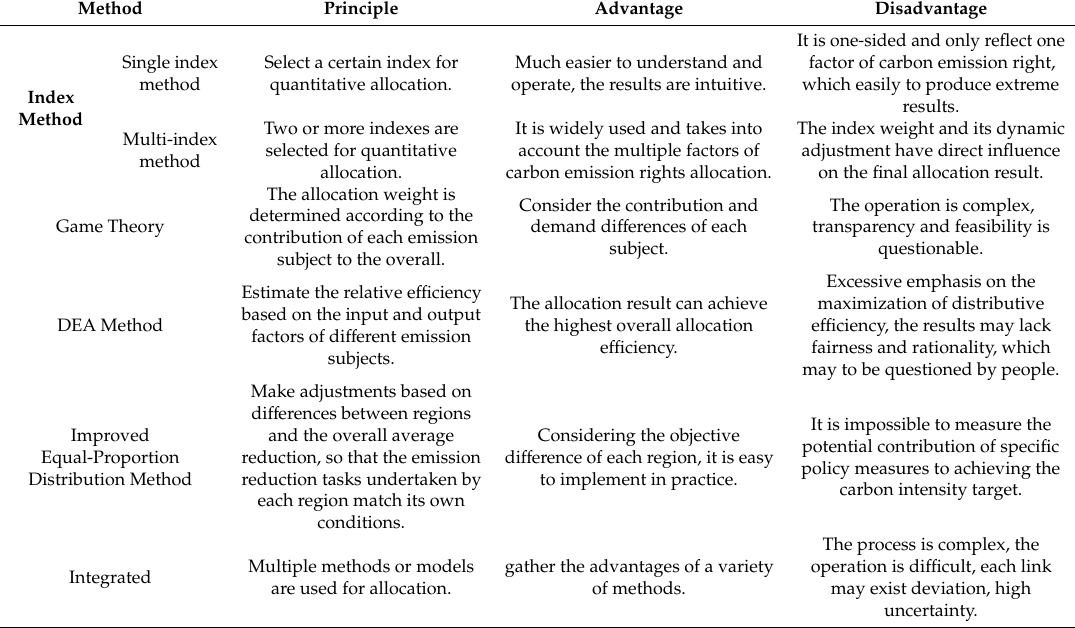
Table 1. Allocation methods of carbon emission reduction